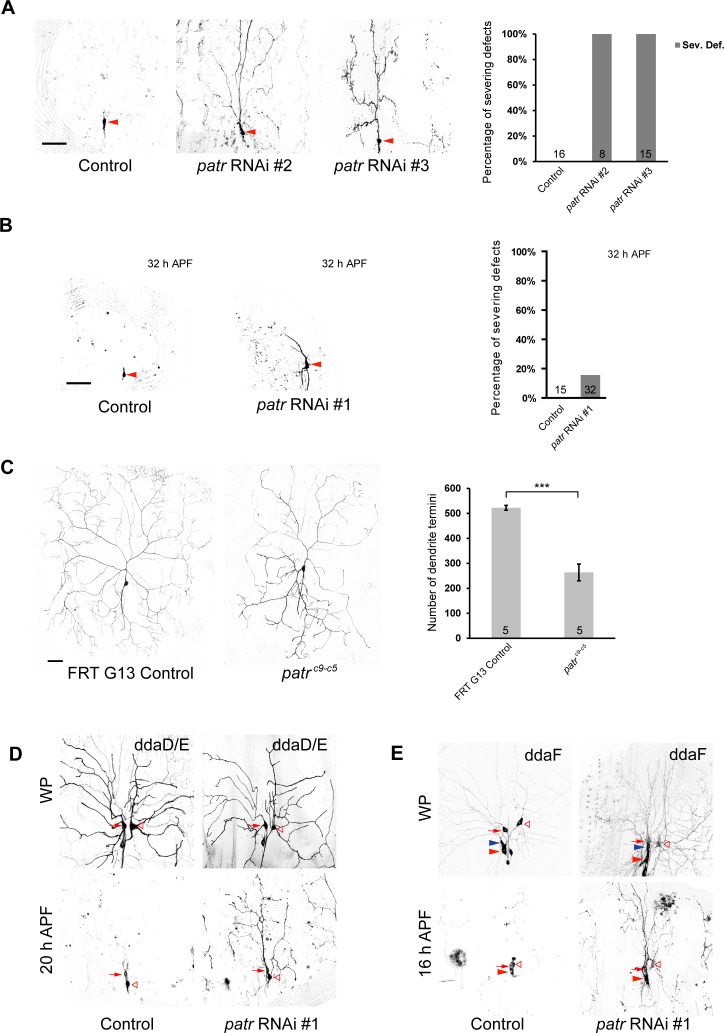
Patronin is required for dendrite pruning and arborization in sensory neurons.(A–E) Live confocal images of da neurons expressing mCD8-GFP at w3L, WP, 16 hr and 20 hr, 32 hr APF. (A) While the control neurons pruned all the dendrites at 16 hr APF, ddaC neurons overexpressing patronin RNAi #2 or patronin RNAi #3 by ppk-Gal4 exhibited dendrite pruning defects at 16 hr APF. Red arrowheads point to the ddaC somas. Quantification of the severing defects in control and mutant ddaC neurons at 16 hr APF. (B) ddaC neurons overexpressing patronin RNAi #1 by ppk-Gal4 pruned away most of their dendrites at 32 hr APF. Red arrowheads point to the ddaC somas. Quantification of the severing defects in control and mutant ddaC neurons at 32 hr APF. (C) Compared to FRT G13 control, patroninc9-c5 ddaC MARCM clones exhibited simple dendrite arbors at wL3 stage. Quantification of number of dendrite termini in control and patroninc9-c5 ddaC MARCM clones. (D) While the control class I ddaD/ddaE neurons labelled by Gal42-21-driven mCD8-GFP pruned their larval dendrites at 20 hr APF, patronin RNAi #1 ddaD/ddaE neurons failed to do so. Red arrows point to the ddaD somas and open arrowheads to the ddaE somas. (E) Like control ddaF neurons, patronin RNAi #1 ddaF neurons labelled by Gal4109(2)80-driven mCD8-GFP were also eliminated by 16 hr APF. Red arrowheads point to the ddaC somas, and blue arrowheads point to the ddaF somas. Error bars represent S.E.M. The number of samples (n) in each group is shown on the bars. Scale bars represent 50 µm. ***p<0.001 as assessed by two-tailed Student’s t-test.10.7554/eLife.39964.004Figure 1—figure supplement 1—source data 1.Extended statistical data as Microsoft Excel spreadsheet.